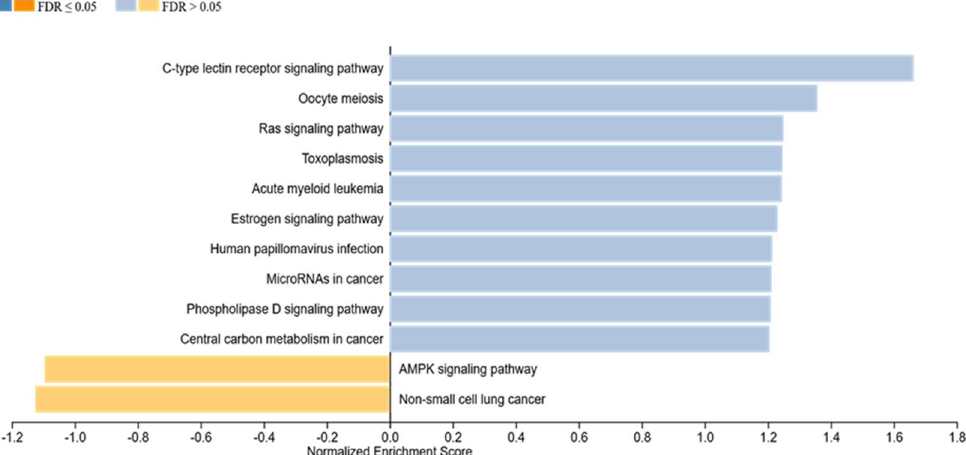
Figure 4. Gene set enrichment analysis in relation to apoptosis in MPM cells being treated with FB CM. Particularly, the MAPK− RAP1 and the Fc receptor signaling pathway showed significant as- sociations. These pathways were activated in treated MPM cell lines.